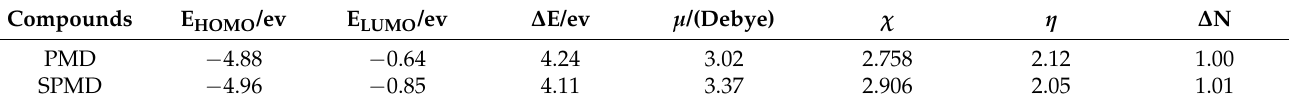
Table 5. Quantum chemical parameters of perimidine